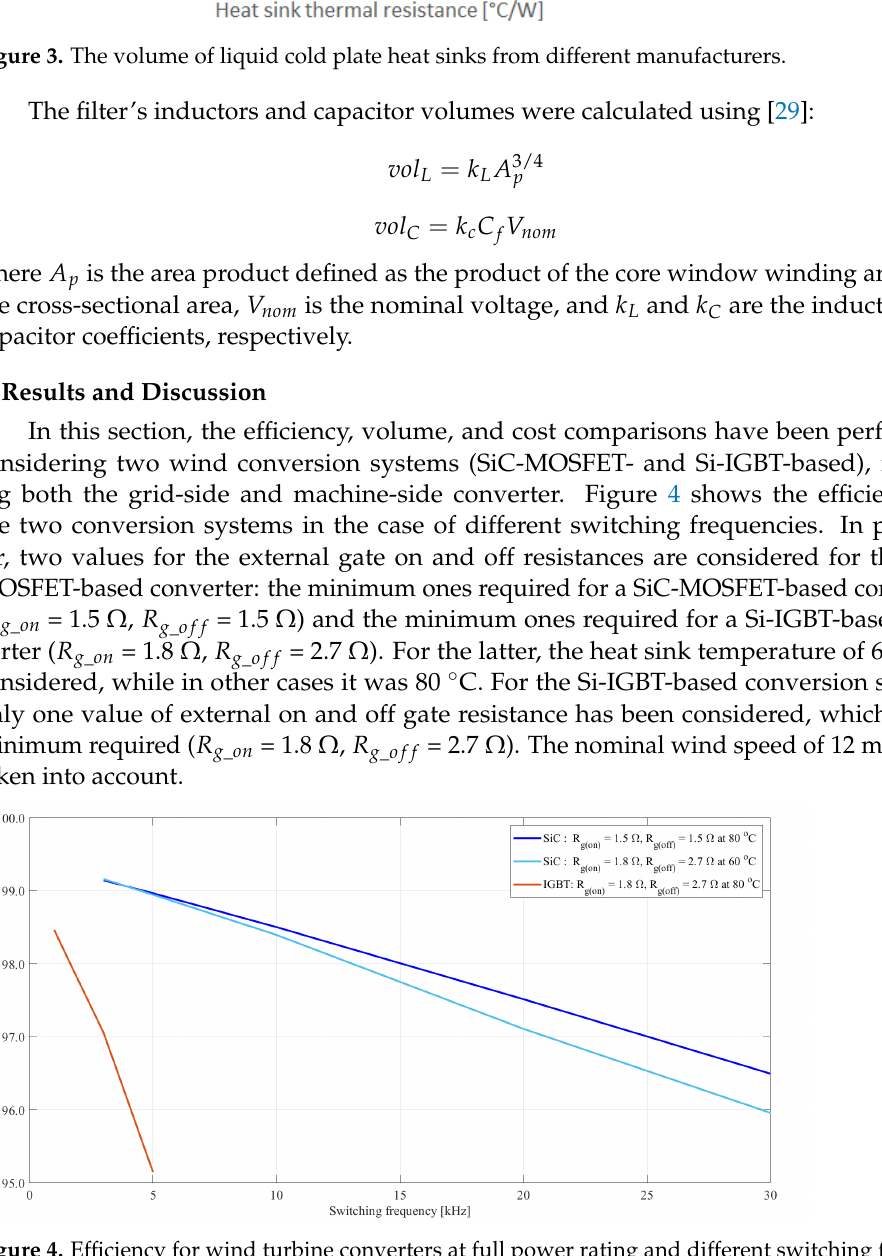
Figure 4. Efficiency for wind turbine converters at full power rating and different switching frequen- cies and external gate